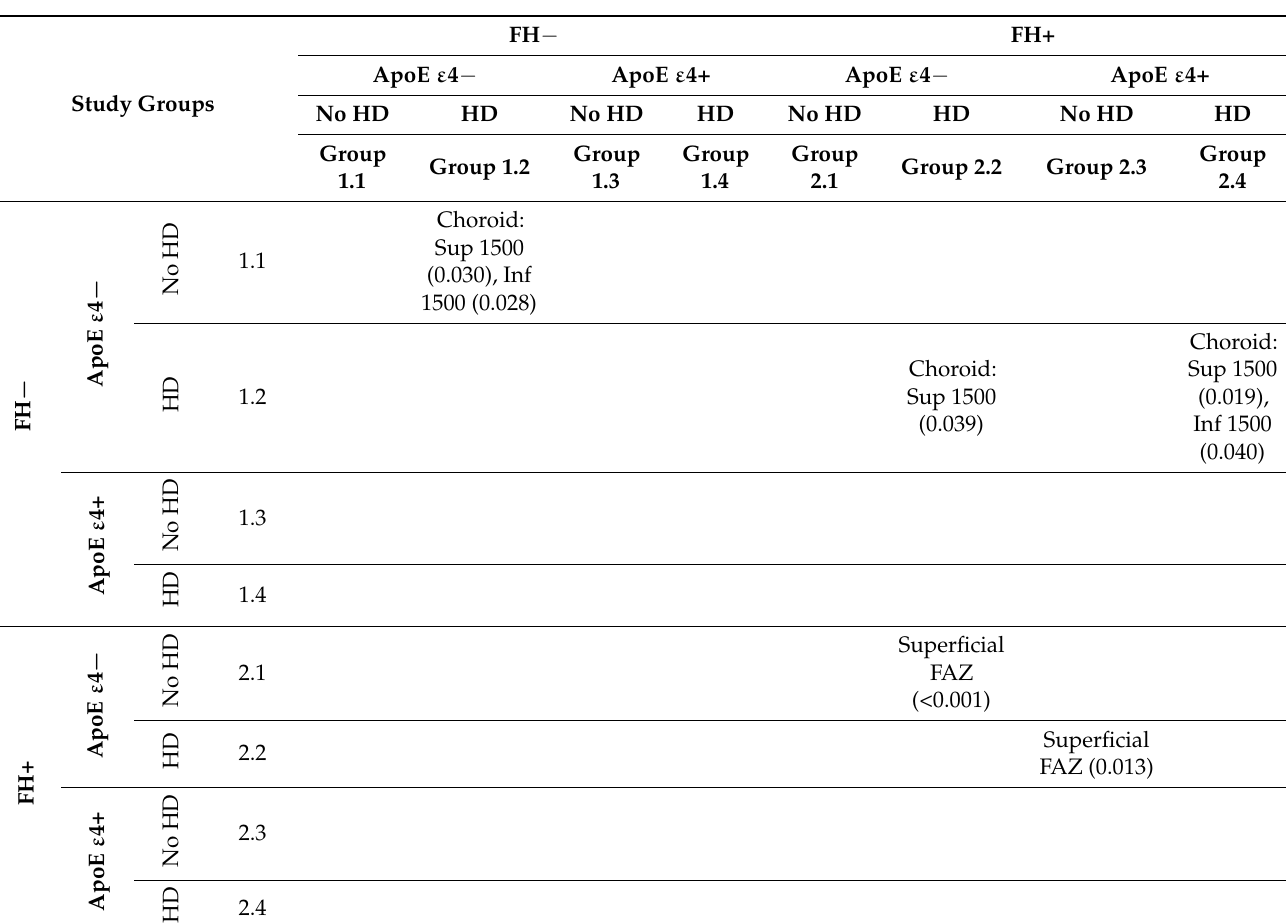
Table 4. Significant p − values for differences between groups in the FAZ and choroidal thickness. p − values are in parentheses.